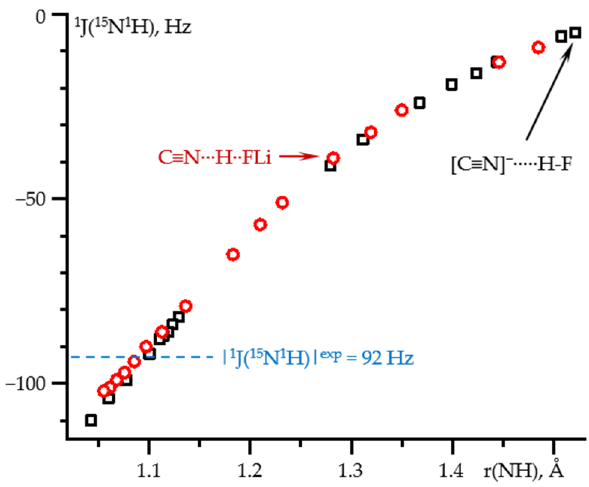
Figure 6. 1 J( 15 N 1 H) as a function of the N-H distance in C ≡ N-H . . . F − (black squares) and C ≡ N-H . . . FLi (red circles) complexes at PCM = water and the effect of the external electric field. The values in the absence of the field are shown by arrows. The experimental value of 1 J( 15 N 1 H) in CDF 3 /CDF 2 Cl at 130 K is shown by a blue line [69].